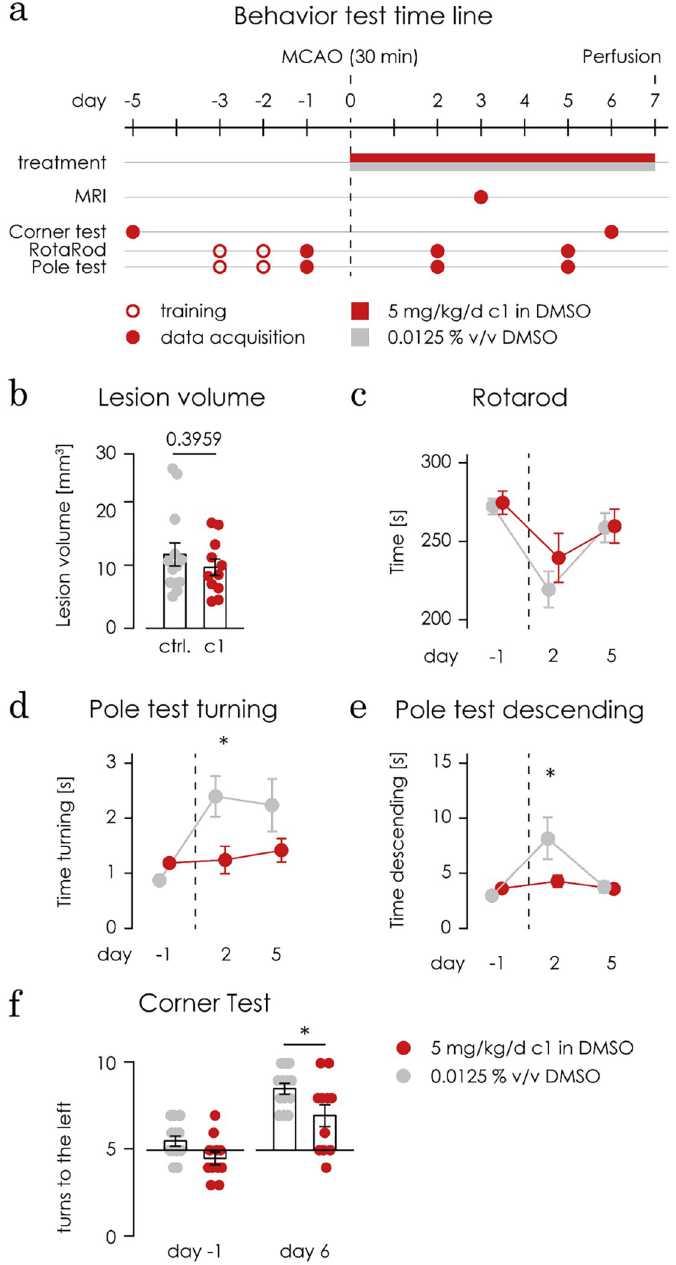
Fig 5. C1 improves behavioural deficits after mild brain ischemia. a) The scheme shows the experimental paradigm. Male C57Bl/6 mice were submitted to 30 minutes of middle cerebral artery occlusion (MCAo), as a model for mild ischemic injury (indicated by the dashed vertical line). From the day of the MCAo surgery until day 6 after MCAo, mice were injected i.p. daily with 5 mg/kg of C1 diluted in 125x10 -5 v/v DMSO as a vehicle (n = 11) or with just the vehicle (125x10 -5 v/v DMSO in PBS) as control (n = 13). The motor coordination (accelerated Rotarod) and extrapyramidal motor locomotion (pole test) were assessed at day 2 and 5 after MCAo, mice were trained for the both tests on day 3 and 2 before MCAo and baselines were taken on the day before MCAo. The corner test was used to test mice’s laterality on day 6 after MCAo by counting the amount of turns to the left in a total of 10 trials which was then compared to each mouse individual baselines, taken 5 days before MCAo. On day 3 after MCAo, MRI scans were performed to determine the volume of the ischemic lesion. b) The treatment of mice with C1 (in red) did not cause a significant difference (p = 0.3959) in the volume of the ischemic lesion, measured with MRT in comparison with the controls (in grey), using an unpaired t test. c) There are no differences between the treated group (in red) and the controls (in grey) in the Rotarod test, using a 2way ANOVA test. d) During the pole test, the C1-treated group